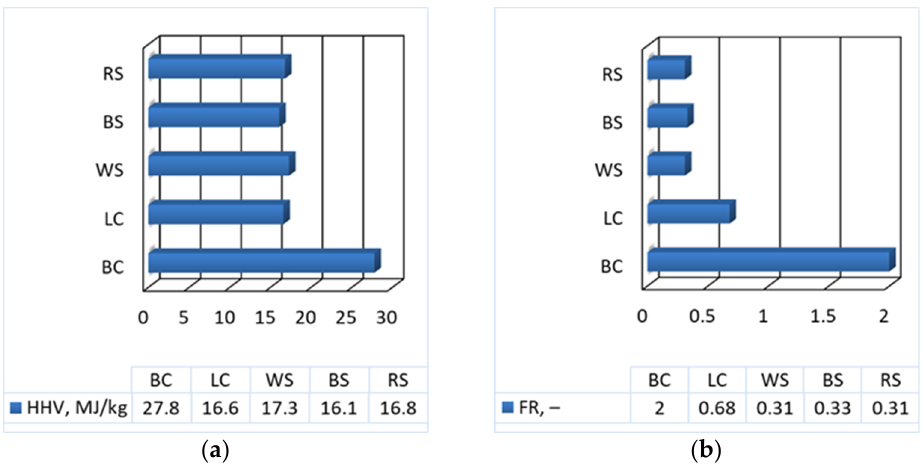
Figure 5. Characteristics of the tested fuels: ( a ) heating value (HHV) and ( b ) fuel ratio (FR). The oxide composition of the ash from selected fuels (determined by the Thermo iCAP 6500 Duo ICP plasma spectrometer method using ASCRM-010), is shown in Figure 6.